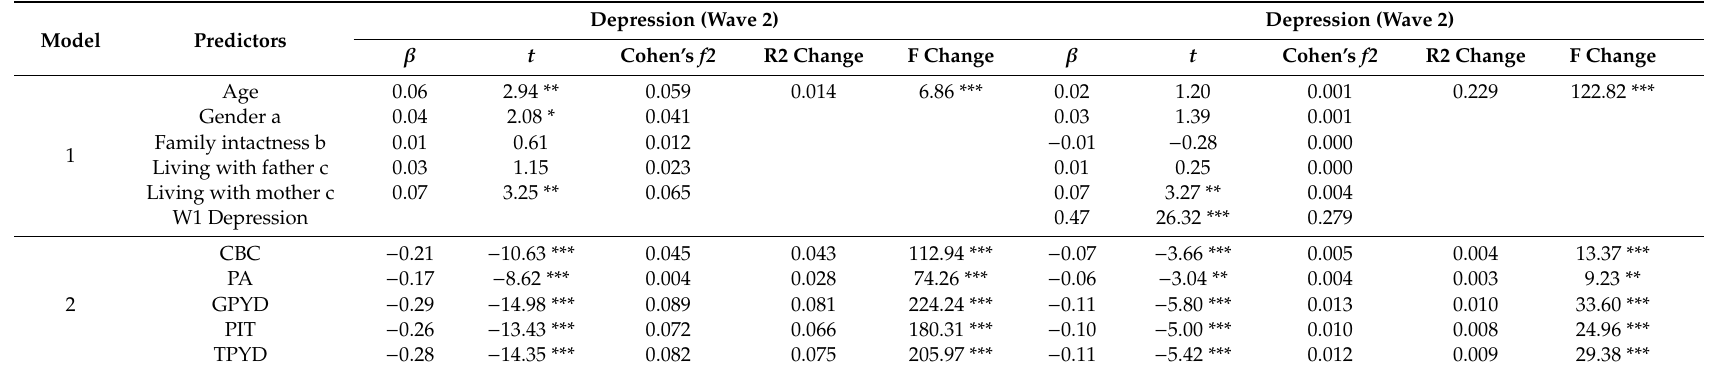
Table 4. Longitudinal regression analyses for